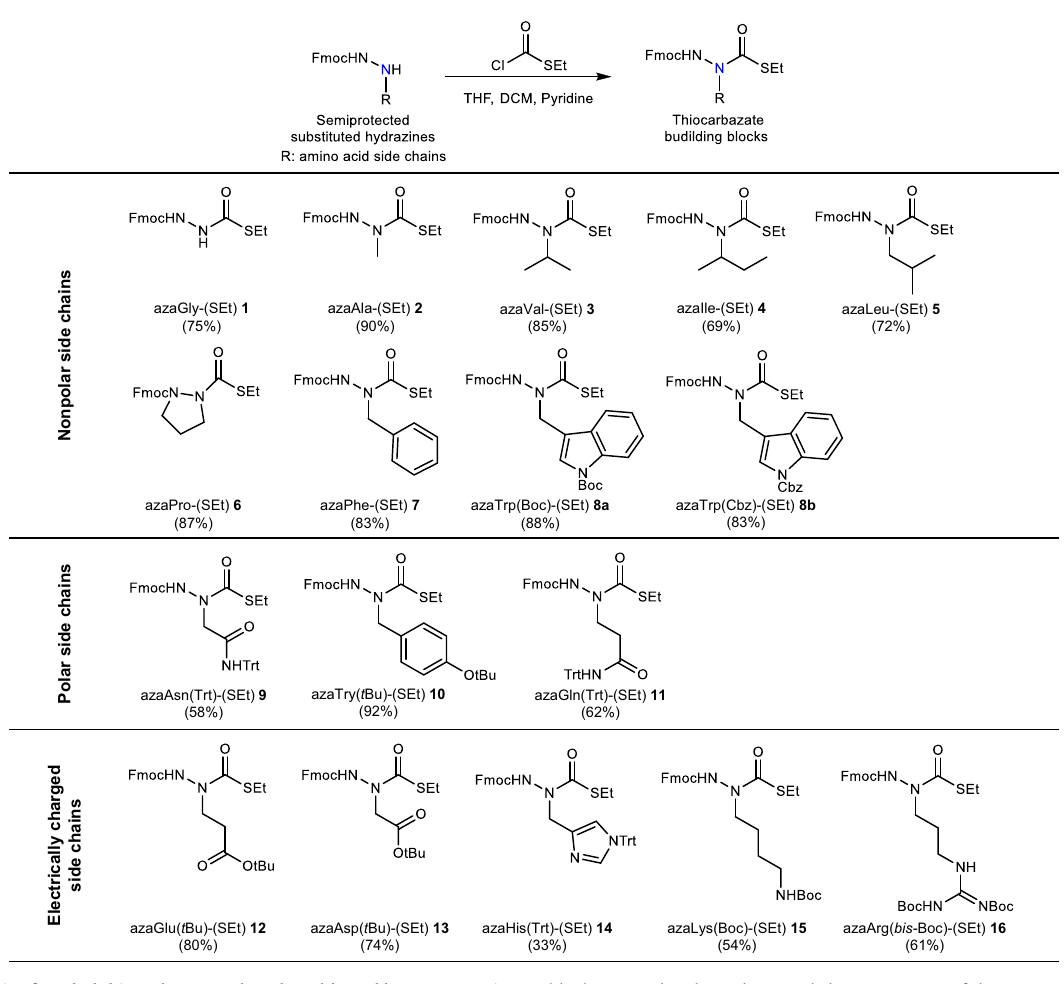
blocks are outlined. Synthesis and characterization of these aza-amino acid con- jugates are detailed in Supplementary